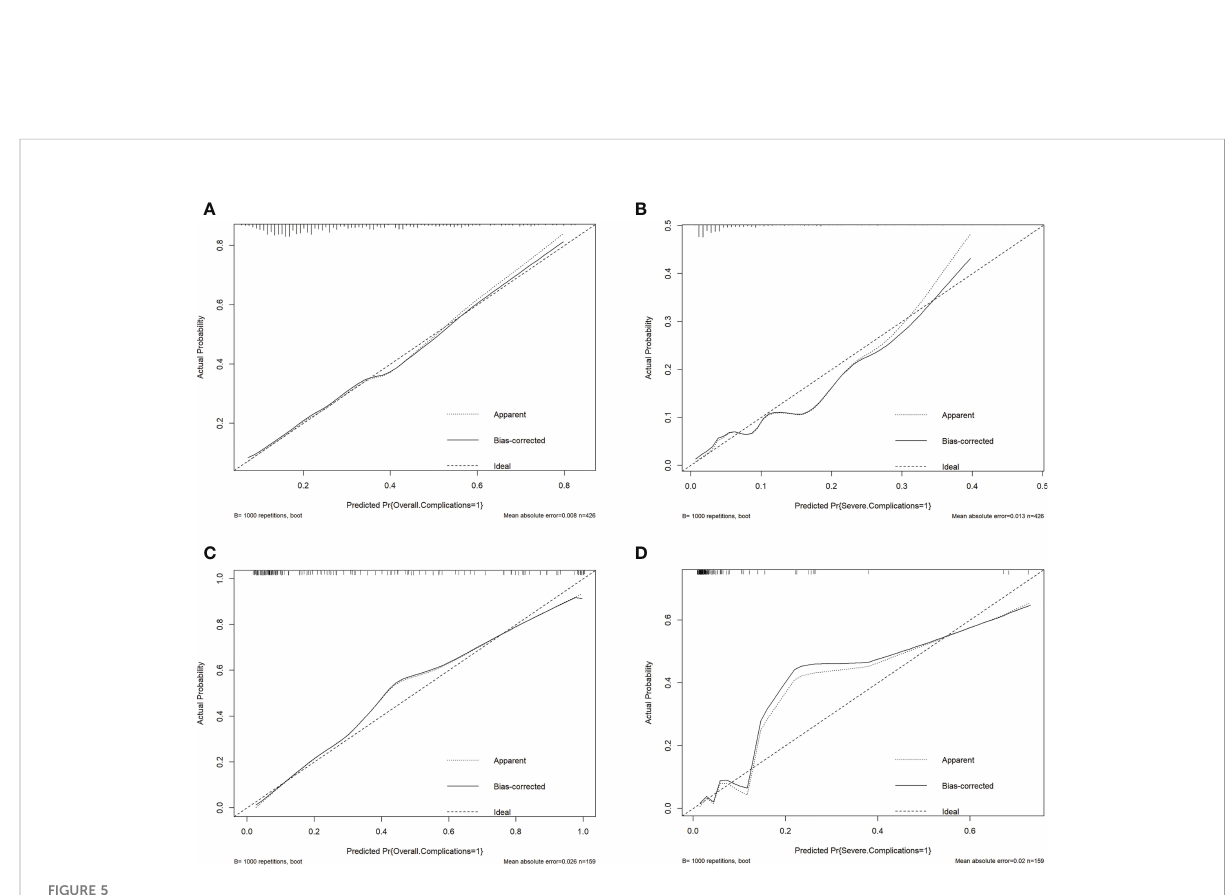
FIGURE 5 Validation plots for evaluating nomogram calibration (1). Internal validation in the training cohort. (A) , Nomogram for prediction of overall complications. (B) , Nomogram for prediction of severe complications. (2) Extrapolation in the extrapolation cohort. (C) , Nomogram for prediction of overall complications. (D) , Nomogram for prediction of severe